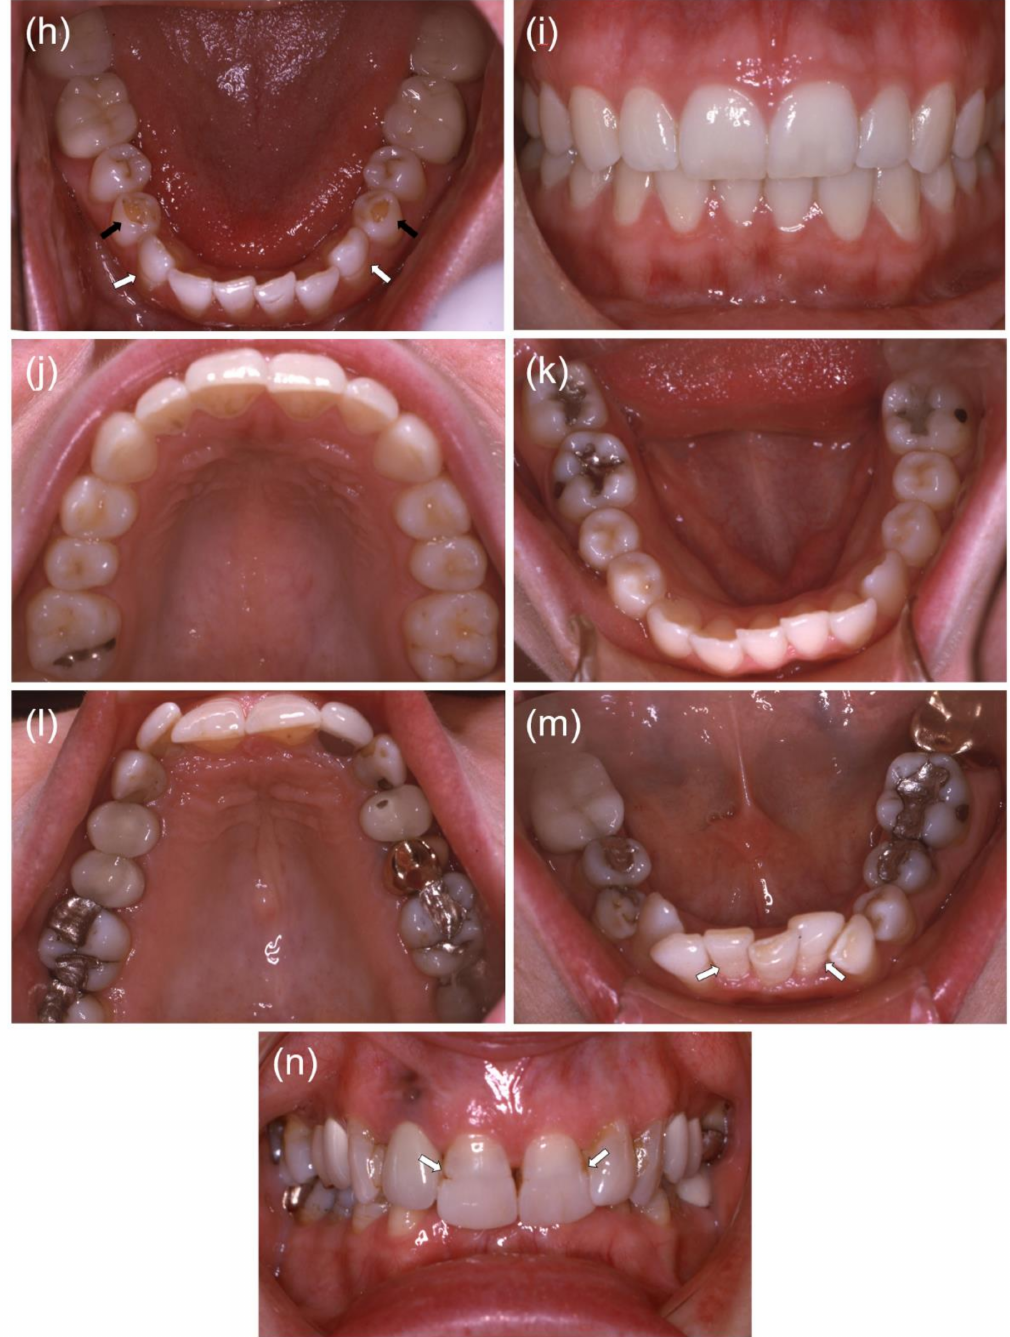
Figure 1. ( a ) Pedigree of the study family. The black arrow denotes the proband. The plus sign (+) indicates participating individuals in this study. The number in the symbol indicates the number of siblings. ( b – d ) Clinical photos of the proband (IV:6). Black arrows indicate hypoplastic enamel defects. The maxillary central incisors look normal, and the mandibular incisors do not show horizontal hypoplastic defects. ( e ) Frontal clinical photo of the grandmother of the proband (II:17). White arrows indicate hypoplastic horizontal grooves. ( f , g ) Clinical photos of the mother of the proband (III:17). White arrows indicate hypoplastic horizontal grooves. Her maxillary anterior teeth were treated with porcelain full crown prosthetics. Hypoplastic defects in the maxillary first premolars are indicated with black arrows. ( h ) Clinical photos of the mother of the proband (III:17). Hypoplastic defects (black arrows) are shown in the mandibular first premolars, and horizontal hypoplastic grooves (white arrows) are shown in the anterior teeth. ( i – k ) Clinical photos of the sister of the proband (IV:4). Her dentition looks normal, without any noticeable hypoplastic enamel defects. ( l – n ) Clinical photos of the grandmother of the proband (II:17). White arrows indicate hypoplastic horizontal grooves in the anterior